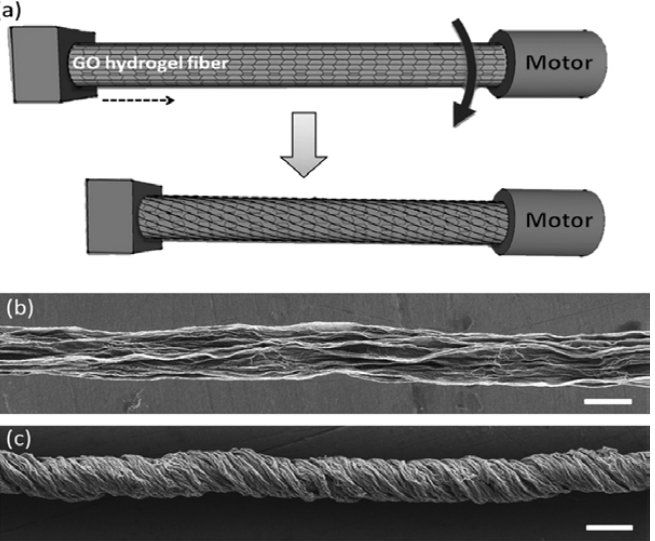
Figure 7. Fabrication and characterization of graphene fiber artificial muscles, ( a ) is the scheme of the graphene fiber fabrication; the arrow indicates the direction of rotation; ( b ) SEM images of the directly dried graphene fiber, and ( c ) twisted graphene fiber (Reprinted with permission from Foroughi, J. et al. [55]. Copyright 2020, CC BY 4.0 International). Along with graphene’s mechanical properties, it is also the best-known conductor.